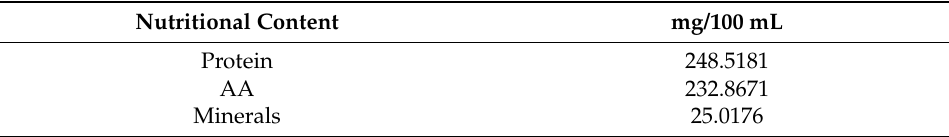
Table 2. Nutritional content of bone broth obtained from bovine femur.